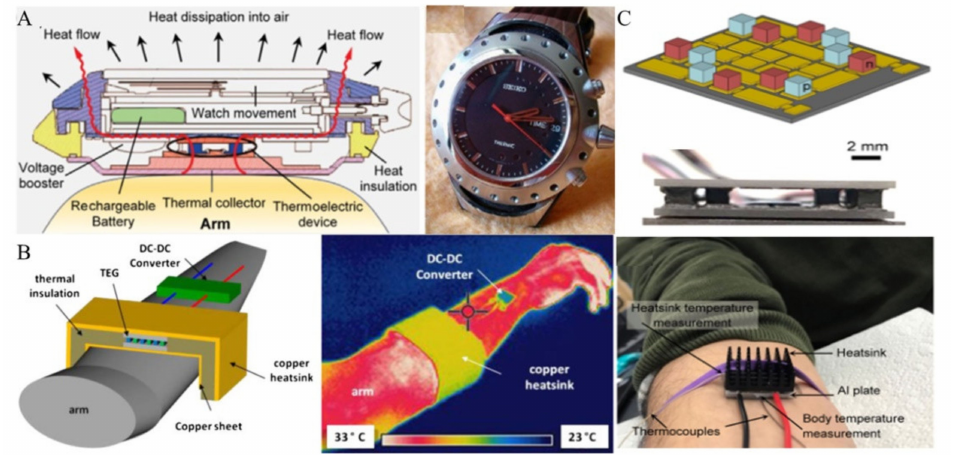
Figure 4. ( A ) The schematic of the Seiko Thermic watch that could generate about 25 µ W from body heat to power the watch [45]. ( B ) Schematic diagram of a low-profile r-WTEGs and infrared image of copper with a high emissivity coating showing effective cooling using the large surface area available in a wristband [47]. ( C ) The schematic of a low FF TEG module and experimental setup used to measure the TEG module on the human body